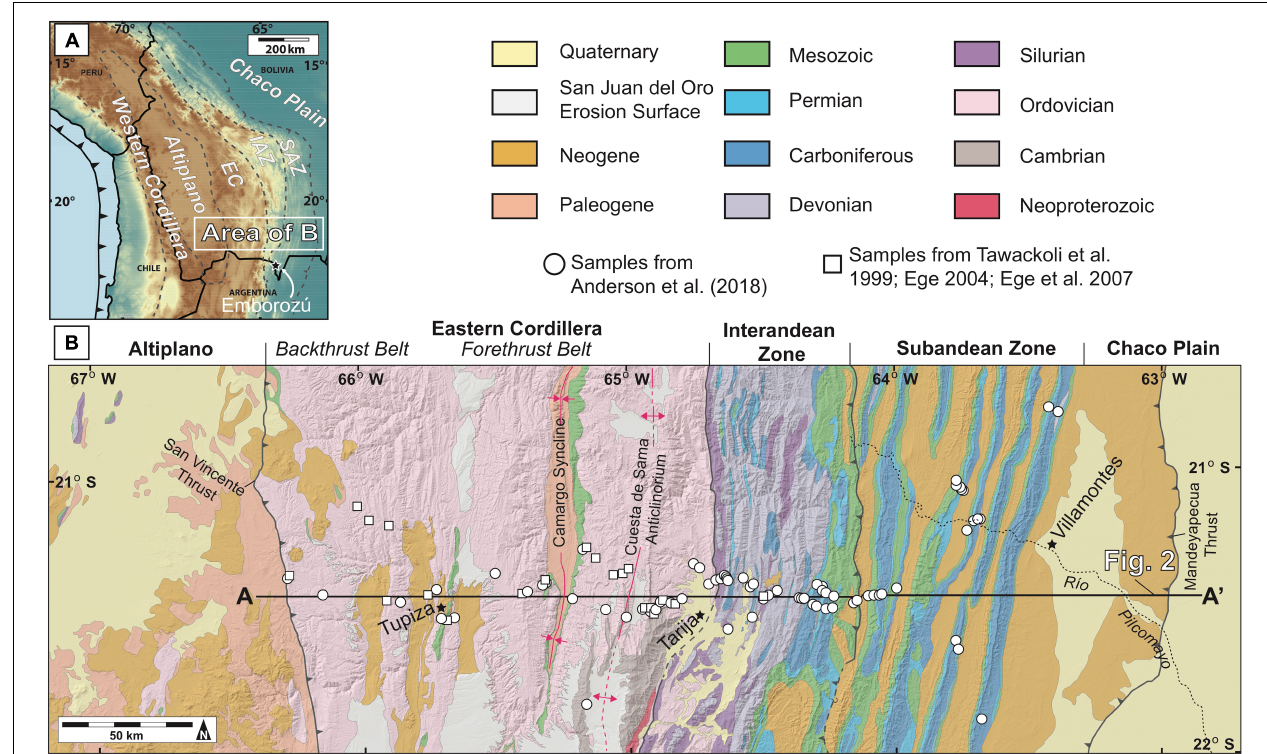
FIGURE 1 | (A) Overview map of the central Andes, showing the location of major tectonomorphic features, Western Cordillera, Altiplano, Eastern Cordillera (EC), Interandean Zone (IAZ), Subandean Zone (SAZ), and the Chaco Plain. (B) Geologic map showing the location of cross section A–A (cid:48) in Figures 3 , 6 , 8 , and thermochronologic data. Villamontes succession shows the approximate site of magnetostratigraphic investigation. Modified from Anderson et al.